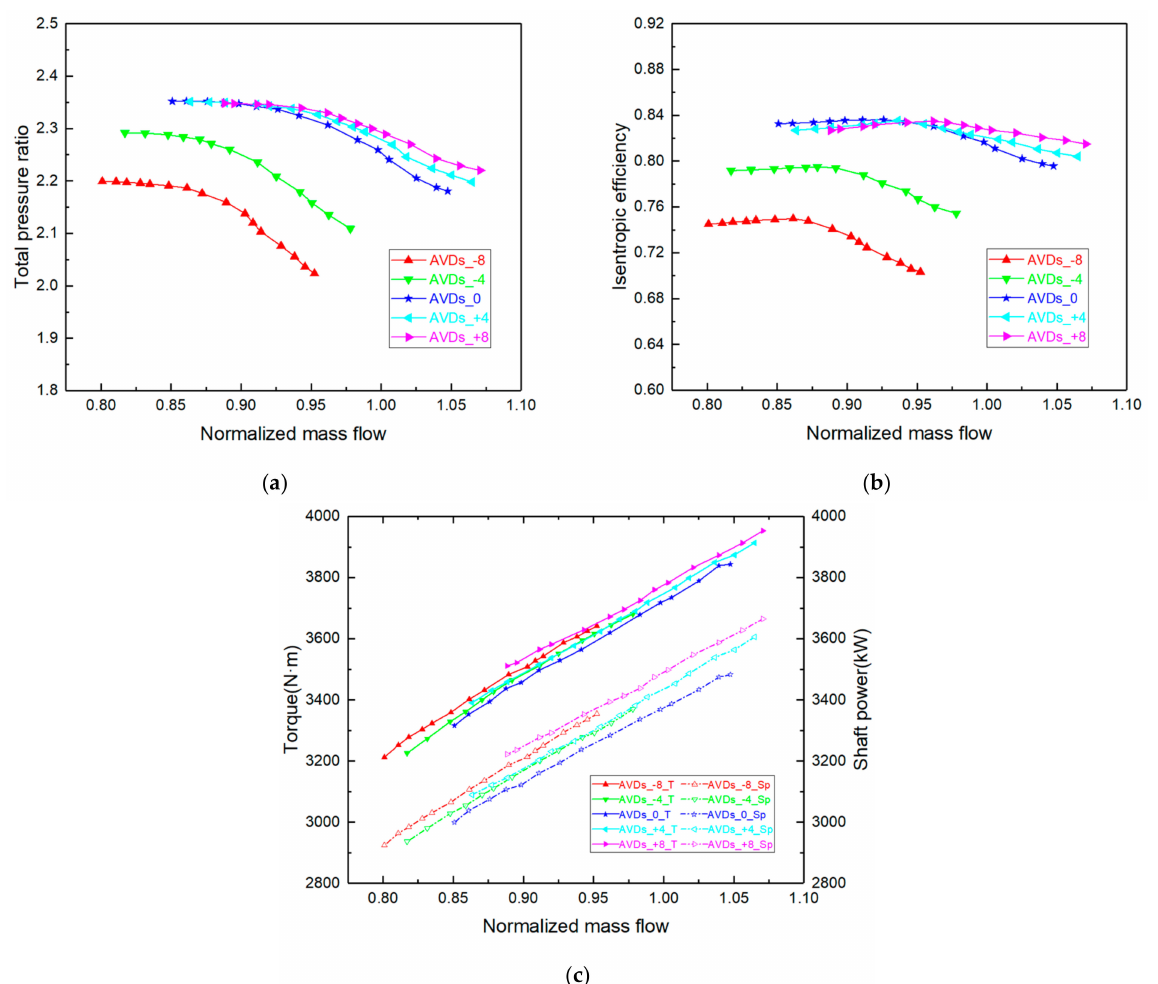
Figure 8. Characteristic curves of centrifugal compressor under variable AVDs’ angles: ( a ) total pressure ratio; ( b ) isentropic efficiency; ( c ) torque and shaft